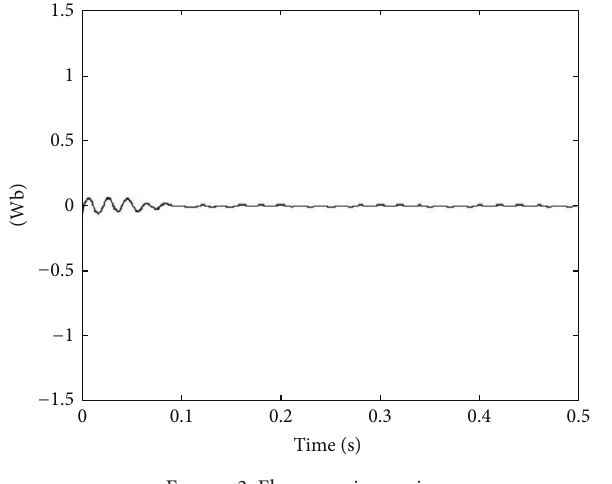
Figure 3: Flux error in 𝑎 -axis.